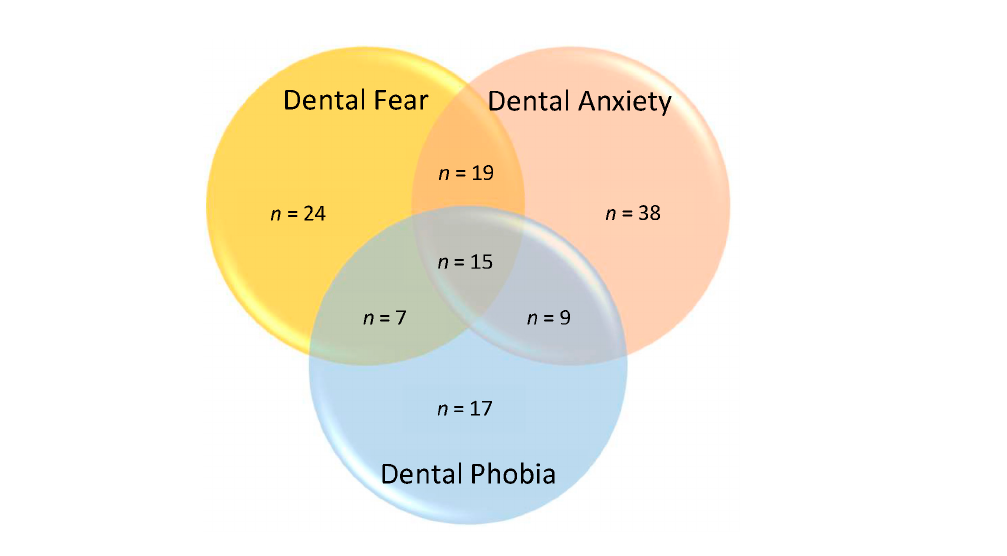
Figure 5. Venn diagram showing how many of the 145 videos mentioned “dental fear”, “dental anxiety”, and “dental phobia”.